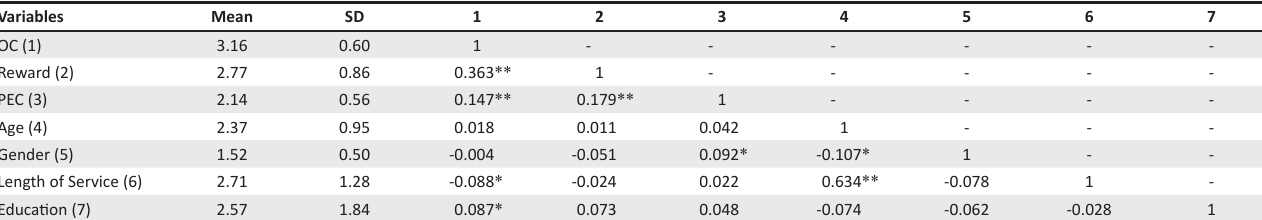
TABLE 4: Correlation